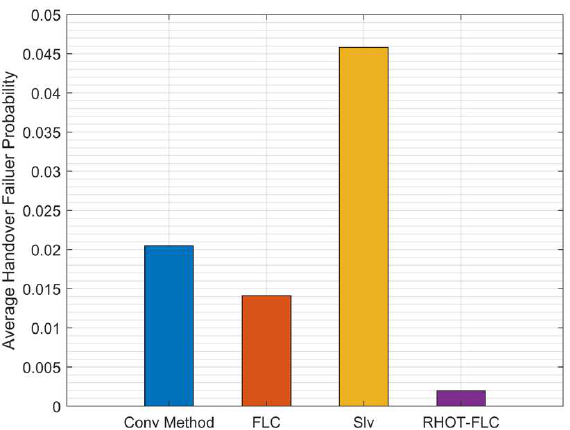
Figure 6. Average HOF probability for overall mobile speed scenarios.